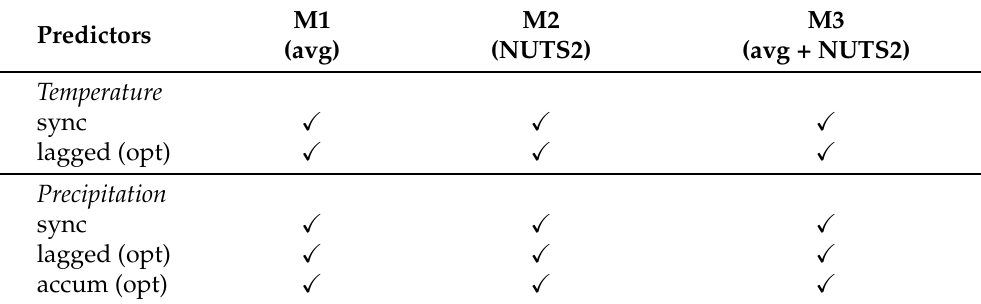
Table 2. Model definition via predictors’